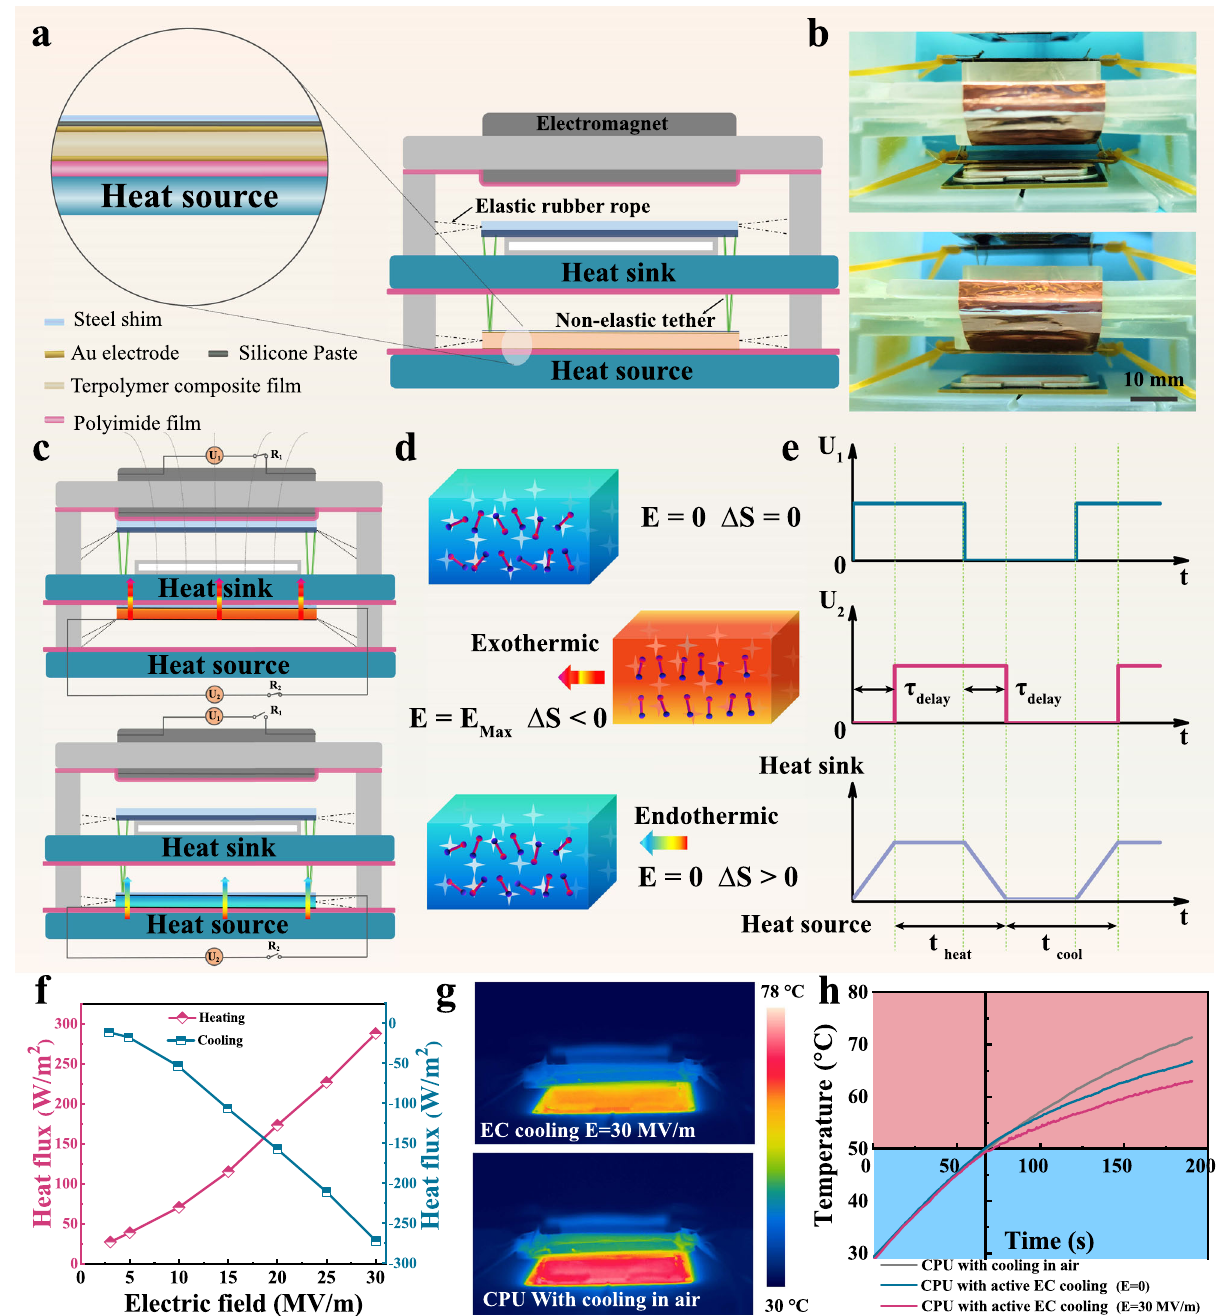
Fig. 3| Asolid-stateelectrocaloriccooling device.a Schematicillustrationofthe electrocaloric polymer stack and solid-state cooling device. b Photograph of the active EC device, the elaborated main framework was obtained by 3-D printing. c The schematic shows how an electromagnetic fi eld drives an electrocaloric polymer stackto move heat from a heatsource to a heatsink.The high-speed heat transfersfromheatsourcetosinkcanbeachievedbyassociatingtheactivecooling of electrocaloric polymer stack with heat dissipation cycle. d The working mechanism of the ECE based on the change of dipole entropy. e Time domain